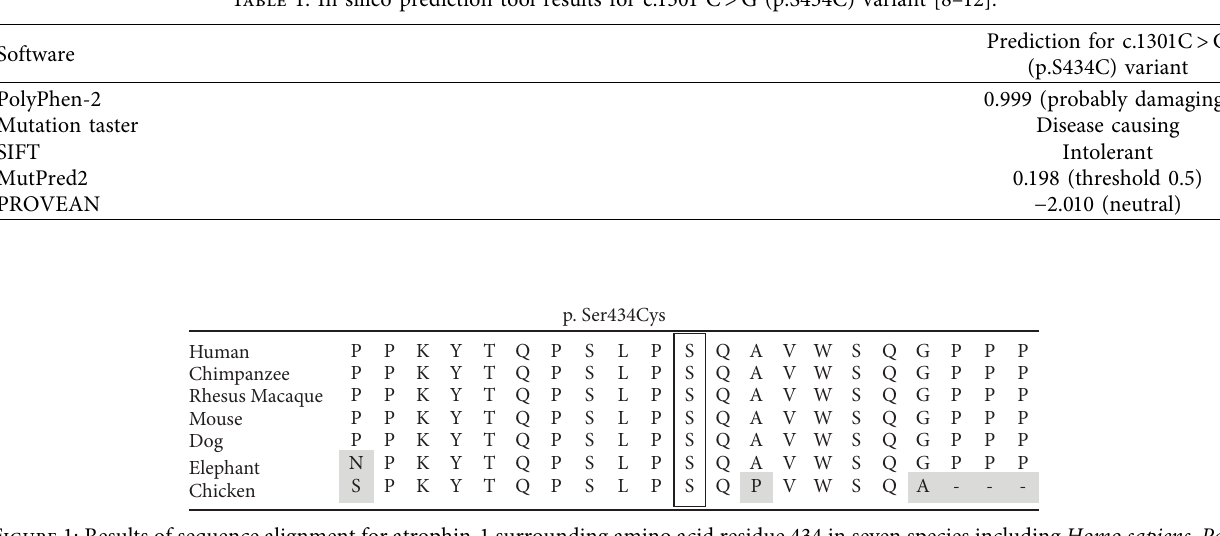
Table 2: Comparison of presence/absence of features in previously documented cases of CHEDDA syndrome and presented case [6, 7]. Presented case